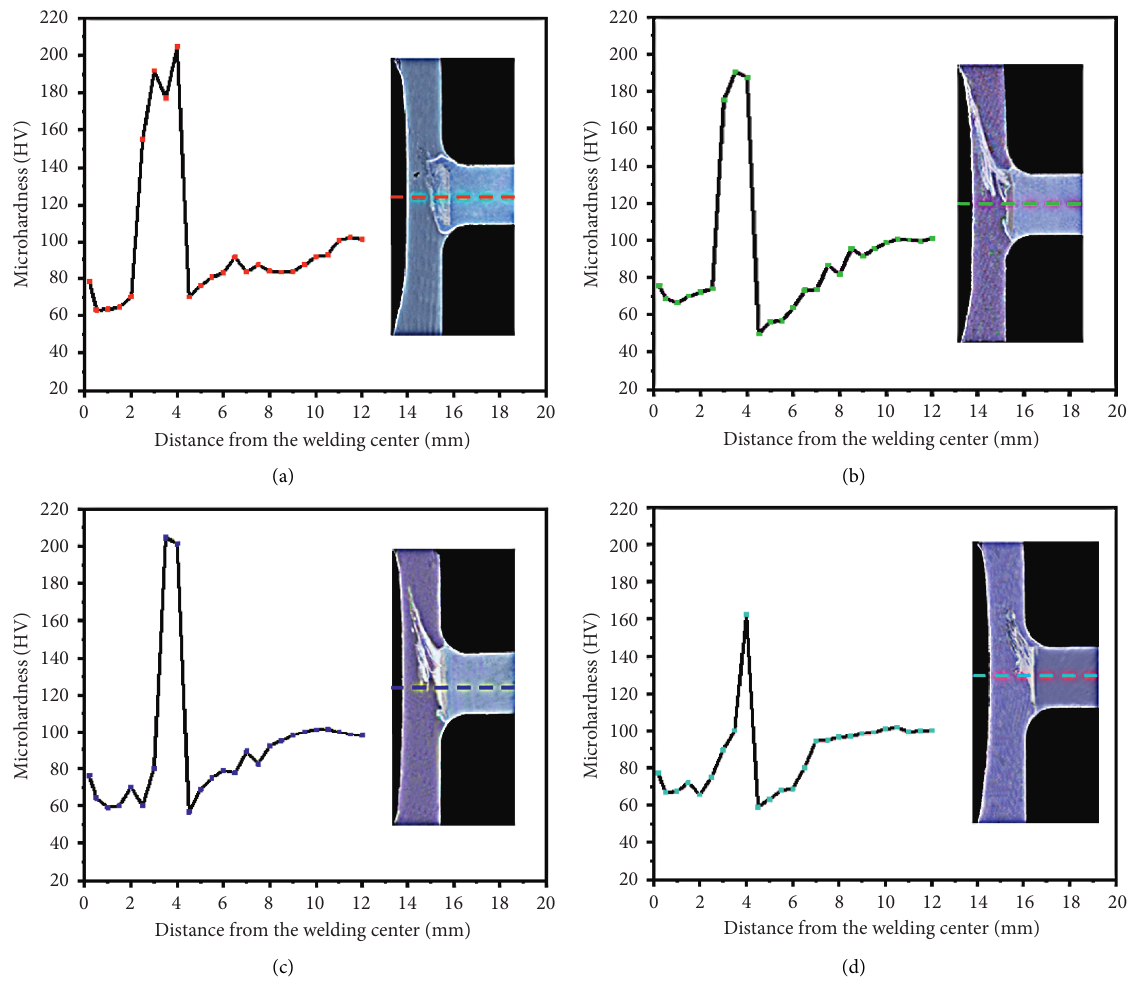
Figure 17: Sketch maps of microhardness tests on the stringers with different traverse speeds: (a) 15mm/min; (b) 30mm/min; (c) 50mm/ min; (d)